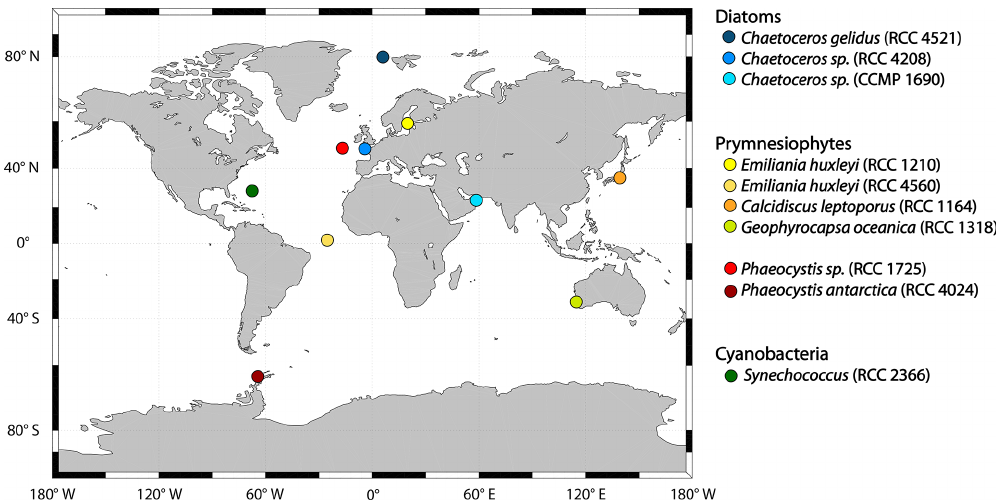
Figure 1. All strains used in the incubation experiments and the original location where they were isolated. Blue colours indicate strains that belong to the group diatoms, yellow to red refers to strains from the class of prymnesiophytes (yellow to orange denotes species from the order of coccolithophores, while red stands for species from the order of phaeocystales) and dark green refers to the only cyanobacteria studied here, Synechococcus sp. Table 2. Overview of results for the control data for the incubation experiments. Start and end points are shown for each measured parameter per type of medium. Values shown are mediums and standard deviations derived from all replicates. Media-only controls were carried out for each incubation set-up with three replicates each and were treated the same way as the inoculated flasks. No significant variations between start and end points were detected in any of the parameters shown with respect to detection limits and precision of the methods. Note that the standard deviations from start and end points are within measurement precision. Additionally, start concentrations of nutrients for each medium are shown (NO − – nitrate, PO 3 − – phosphate, SIO 2 − – silicate, NH + – ammonium). Please note that concentrations of these 3 4 3 4 nutrients were not measured but correspond to the concentrations as stated in the original publications for these media (K; K/2; K + Si: Keller et al., 1987; f/2: Guillard and Ryther, 1962; SN: Waterbury et al.,